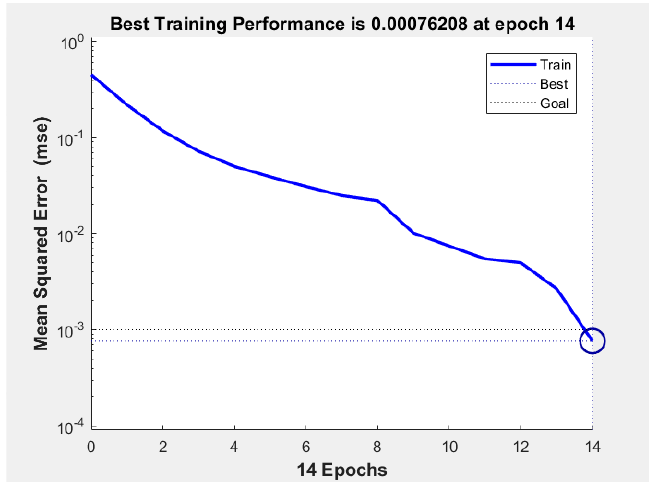
Figure 20. Error convergence curve of neural network.